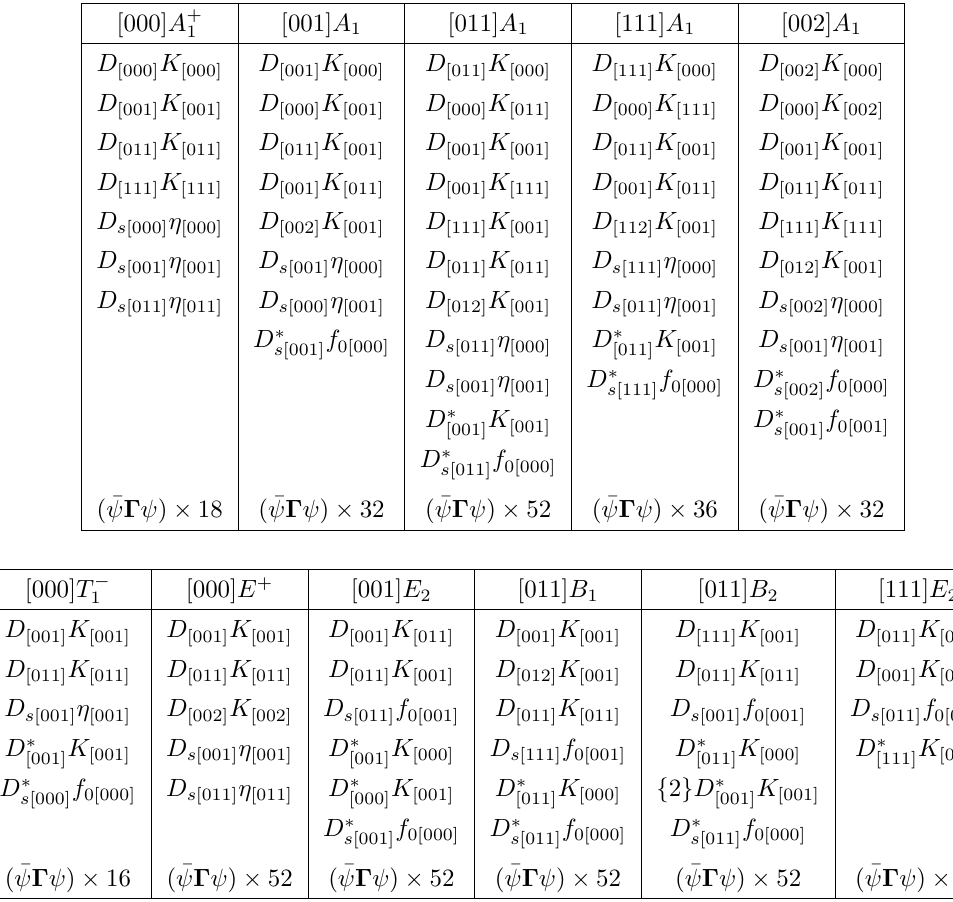
Table 6 . The interpolating operators used in each irrep, [ ~P ]Λ ( P ) , of the DK I = 0 channel on the m π = 239 MeV ensemble. The subscripts on the meson-meson operators refer to the momentum types. The number in braces, { N mult } , denotes the multiplicity of linearly independent two-meson operators if this is larger than one. The number of ¯ qq operators used, n , is indicated by ( ¯ ψ Γ ψ ) × n , where Γ represents some combination of Dirac γ -matrices and up to three (two) spatial covariant derivatives at zero (non-zero) momentum (except only up to two spatial derivatives for [000] T −